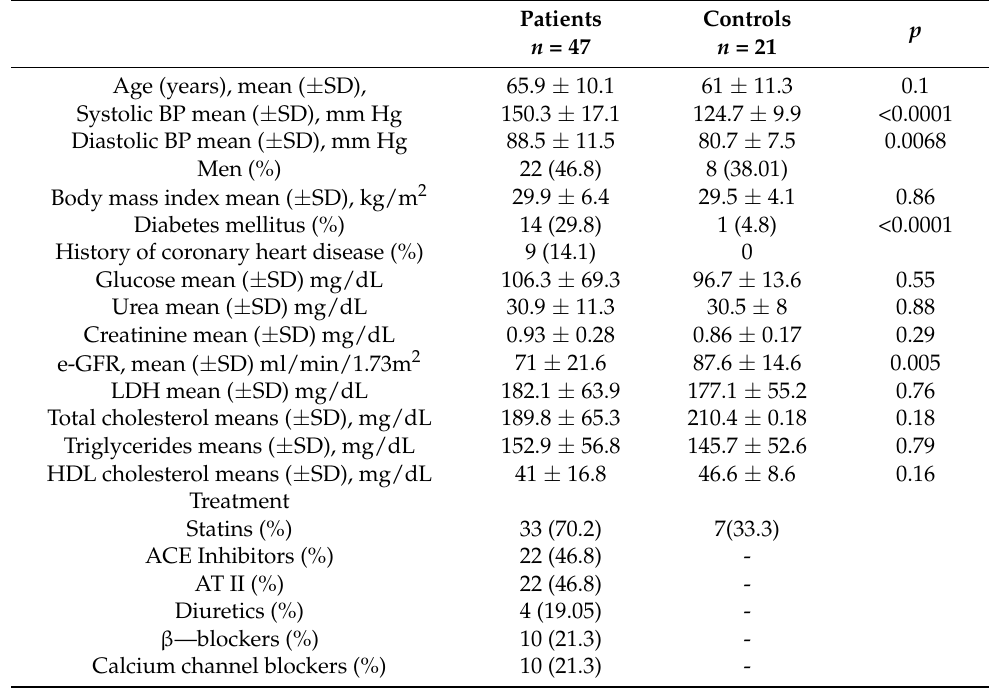
Table 2. Clinical and demographic characteristics of patients with hypertension (cases) and controls. Patients Controls p n = 47 n = 21 Age (years), mean ( ± SD), 65.9 ± 10.1 61 ± 11.3 Systolic BP mean ( ± SD), mm